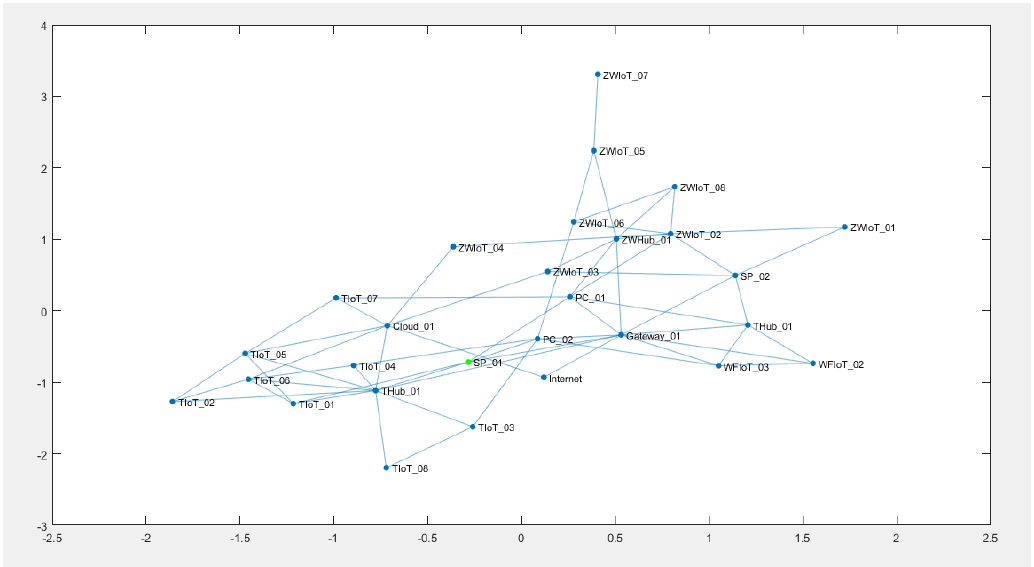
Figure 4. Generated network topology, with node SP01, corresponding to a smartphone device, highlighted.